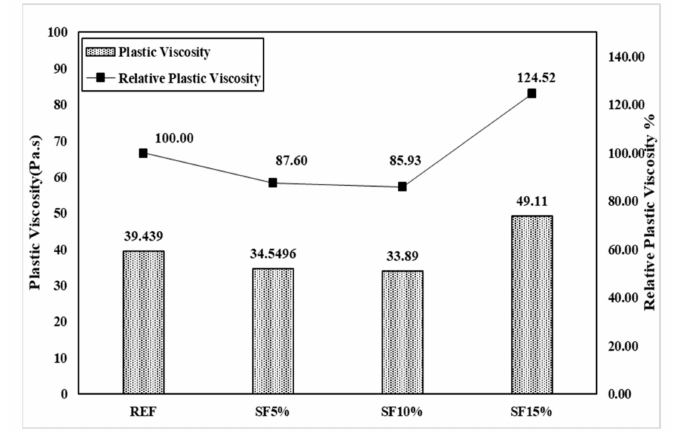
Figure 18. Plastic viscosity ( µ ) of the mixing ratio (Jeon’s